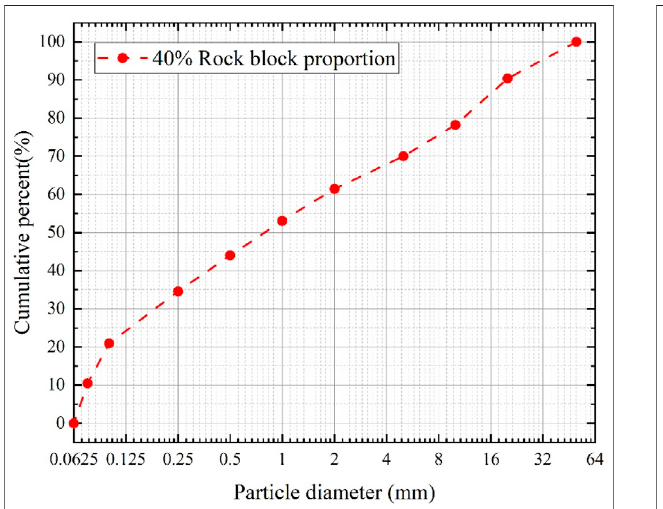
FIGURE 3 | Grains composition of prepared S-RMs.